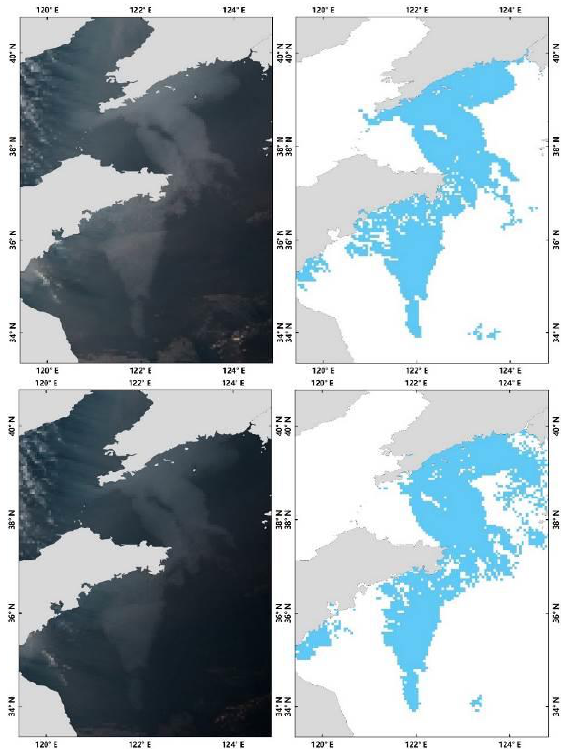
Figure 5. 2017.5.2 Dawn and Dusk Sea Fog Event (top) 10:00 UTC Himawari-8 true colour map and sea fog detection results (middle) 10:10 UTC Himawari-8 true colour map and sea fog detection results (bottom) 10:20 UTC Himawari-8 true colour map and sea fog detection results (blue part is sea fog, gray part is land, white part is other objects)